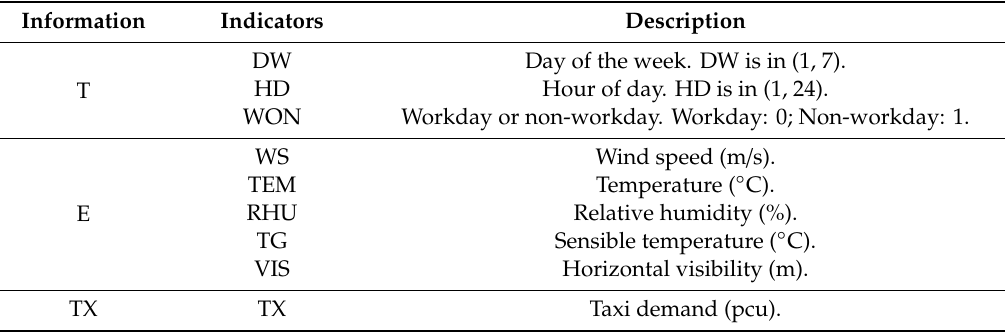
Table 5. Predictive indicators of trip demand.